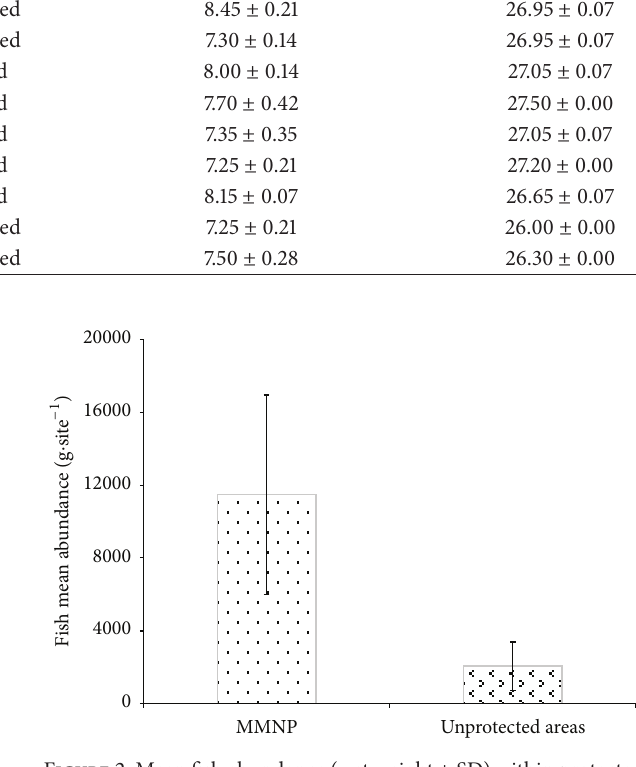
Figure 2: Mean fish abundance (wet weight ± SD) within protected area(MMNP)andunprotectedareas(BuhinguandSibwesa)inLake Tanganyika, Tanzania, during 2008 gillnet survey.